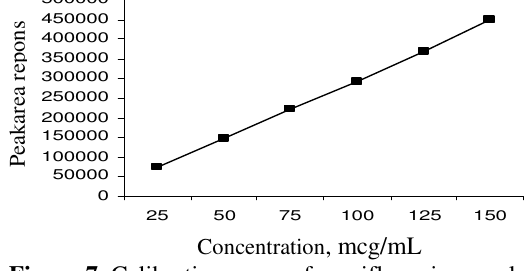
Figure 7. Calibration curve of gemifloxacin mesylate.